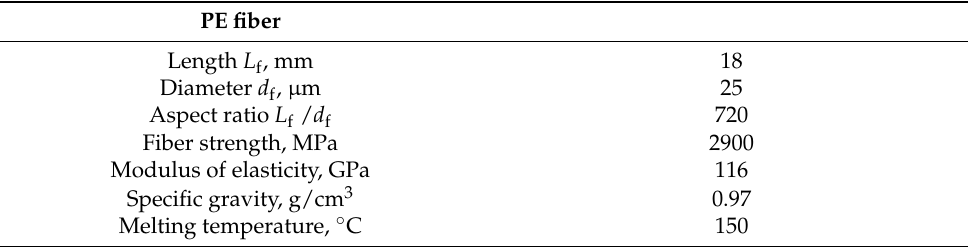
Table 3. Properties of PE fibers *.